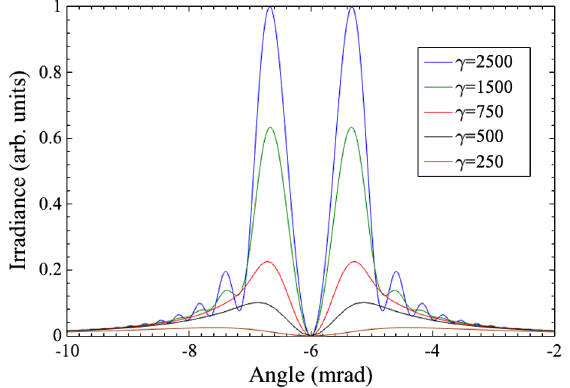
FIG. 4. OTR PSF distribution simulated by ZEMAX for λ ¼ 550 nm and for different energies.